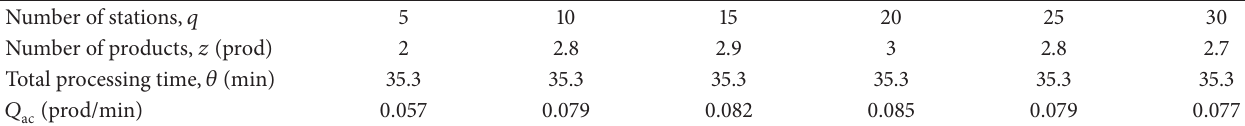
Table 3: Actual productivity calculation.